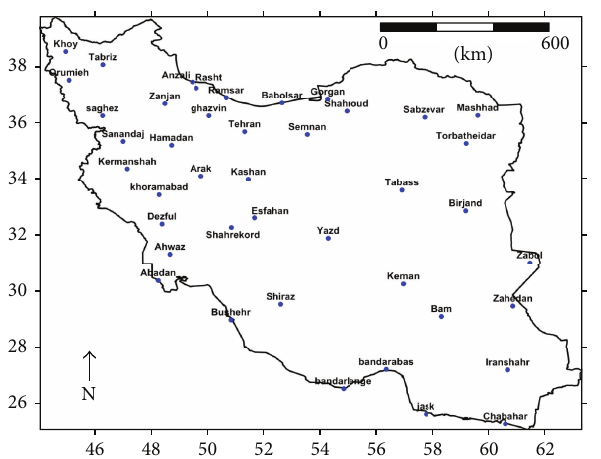
Figure 3: Mean annual precipitation (mm) in Iran, 1951–2007, based on 618 grid points throughout the country.